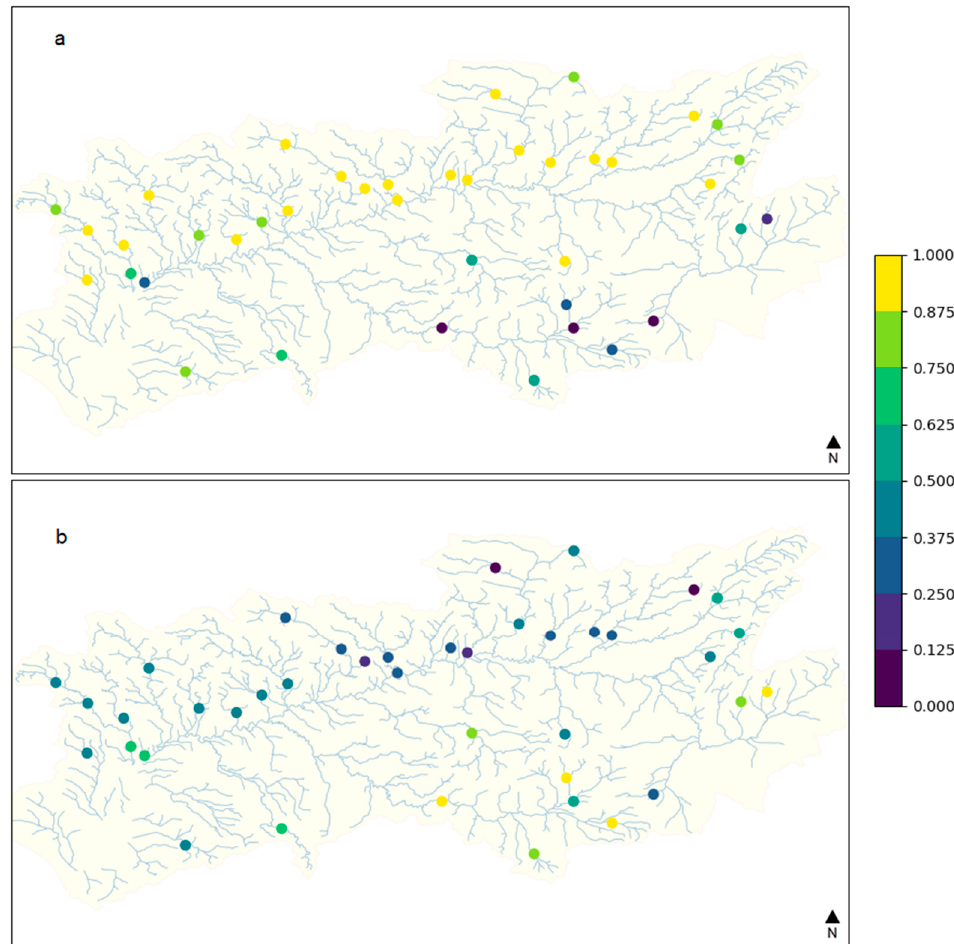
Figure 8. Loadings of ( a ) PC1 and ( b ) PC2 of the continuous series